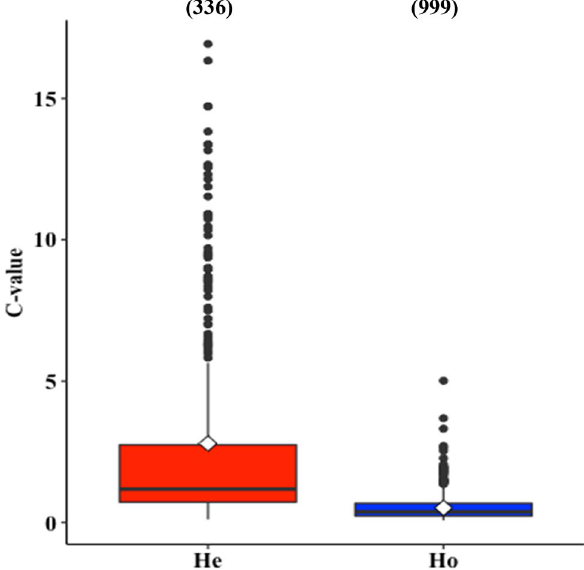
Figure 3. Genome size for insects grouped into hemimetabolous and holometabolous. The C-value (quantity of nuclear haploid DNA) is from a published dataset source (Gregory, 2020; www. genom esize. com). The box plot indicates the variation in the centerline representing median values; boxes extend to the first and third quartiles, whiskers extend to the 1.5 × the interquartile range, and points represent outliers. Diamonds represent group means of 2.79 for hemimetabolans (He) and 0.52 for holometabolans (Ho). Numbers in brackets represent number of observations for each group.